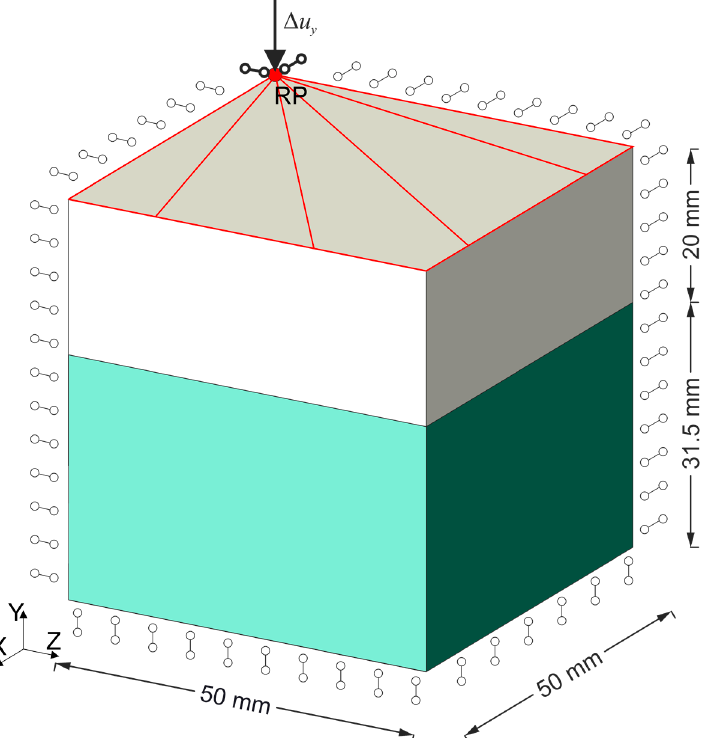
Figure 2. Implementation of the boundary conditions in the upper compression fixture using the MPC option [20,21] is marked in red while the symmetry conditions on the other three faces in the high bearing are shown symbolically.